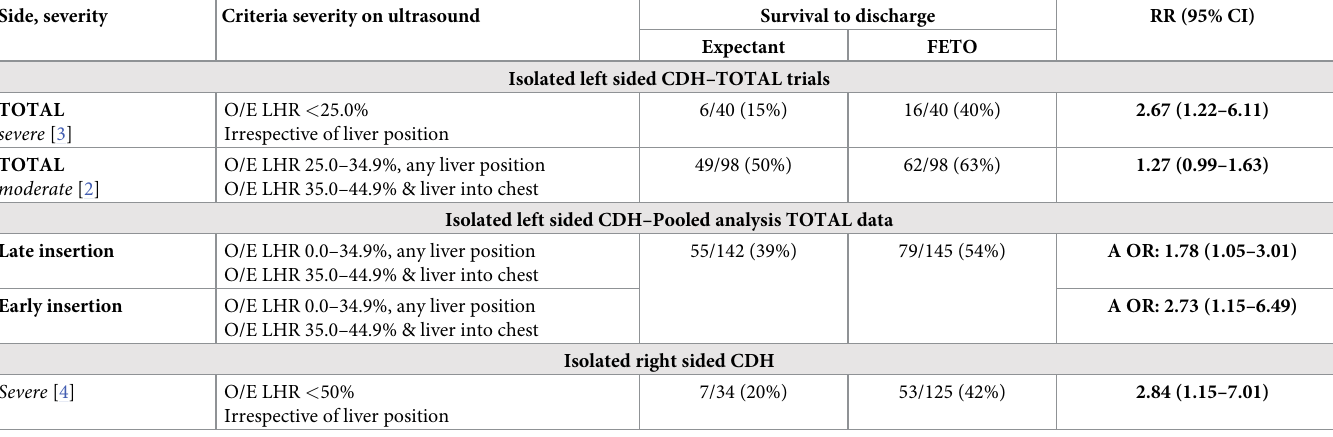
Table 1. Outcomes of fetuses diagnosed with isolated congenital diaphragmatic hernia (CDH) in the prenatal period, either left or right-sided, expectantly managed during pregnancy or having tracheal occlusion within the “Tracheal Occlusion to Accelerate Lung Growth” (TOTAL) trial or and a large study on right-sided CDH under the same management